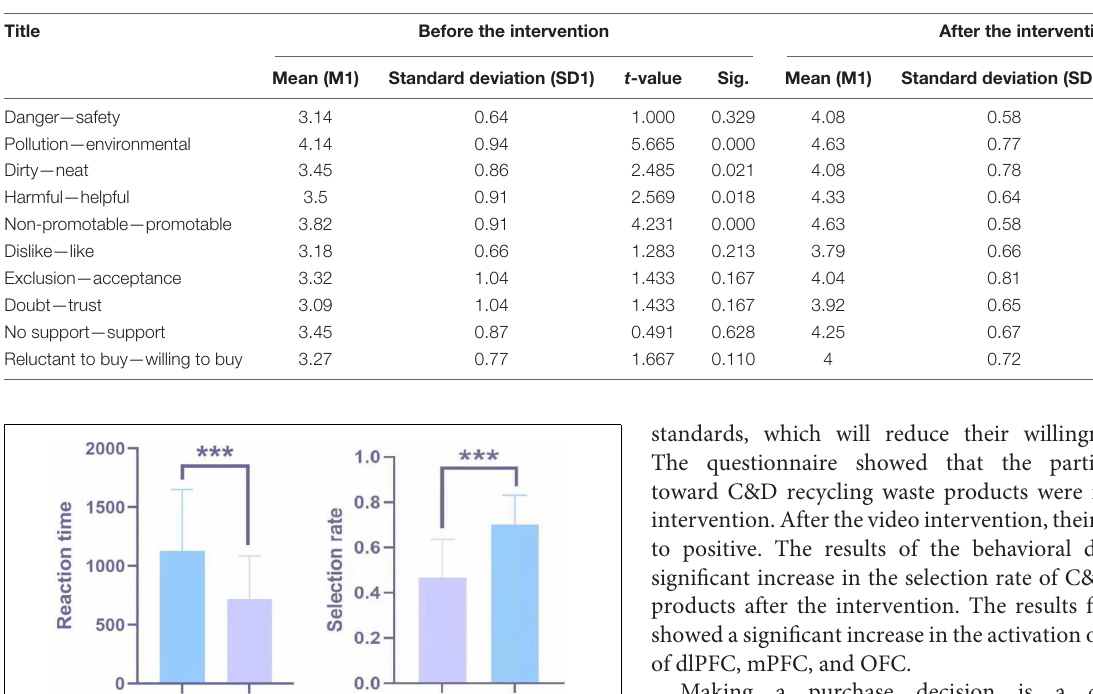
TABLE 1 | Questionnaire scoring.